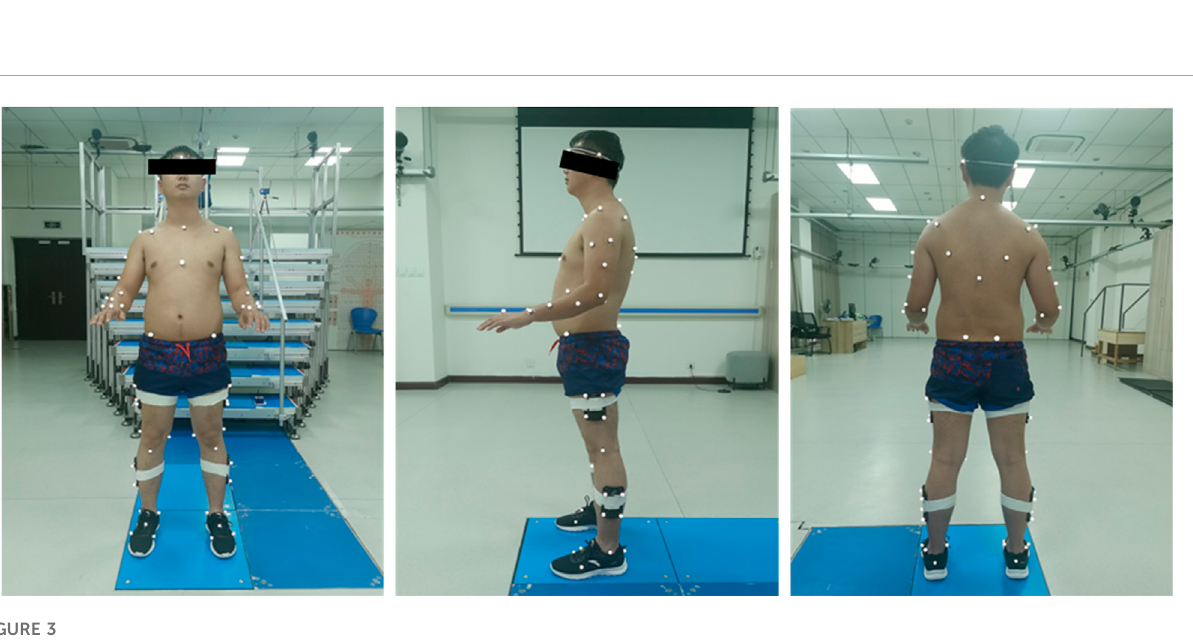
The placement of the